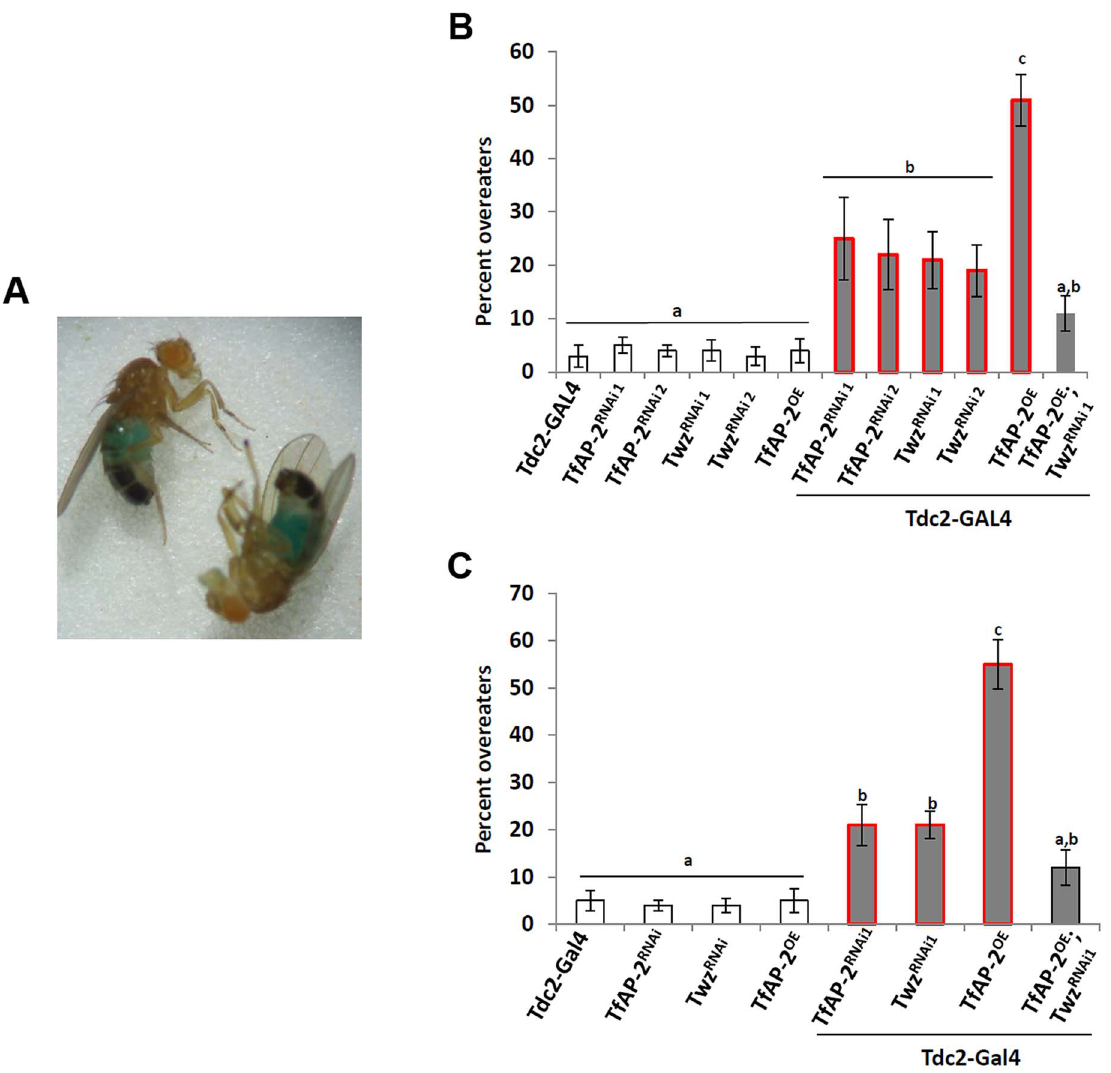
Figure 2. TfAP-2 and Twz regulate feeding behavior after starvation. (A) Ingested dyed-food was visually detected in the abdomen of adult males. (B and B 1 ) After being starved for 16 h male flies were first fed normal food (5% sucrose, 5% yeast and 1% agarose) for 20 minutes, then switched to normal food containing (B) 2% blue food coloring or (C) 2% green food coloring for 10 minutes. After this time the number of flies with blue guts was counted. This assay was repeated at least 5 times with 20 males used for each replicate. (B and C: Different letters indicate similar groups (i.e. ‘a’ is significantly different from ‘b’ or ‘c’ and so on, one-way ANOVA with Bonferroni post hoc test for multiple comparisons, P , 0.05). Error bars represent the SE